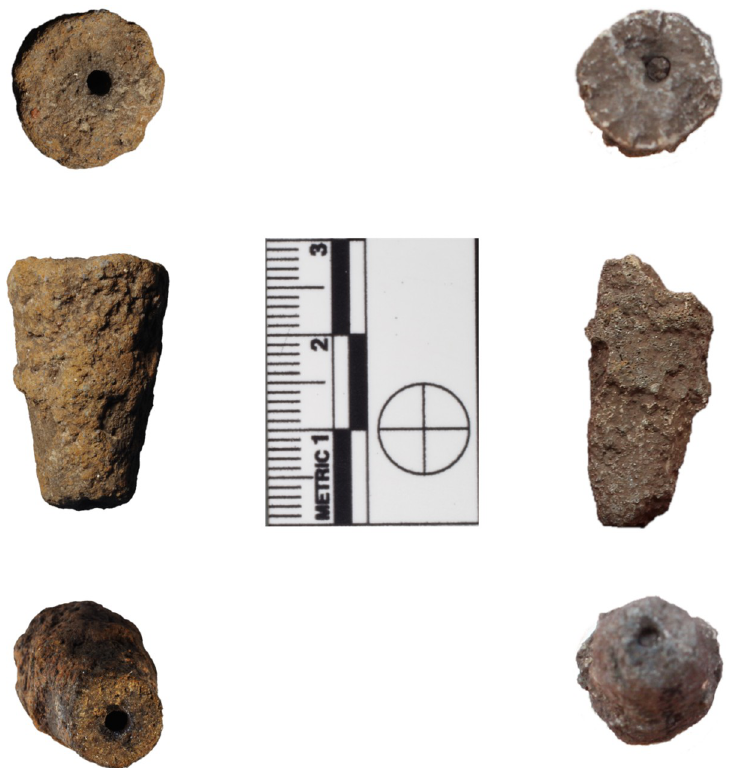
Fig 2. Possible tuy è res. Two tapered cylindrical ceramic pieces with hollow channels from Mayapa´n; we argue that they represent tuy è res, or blowpipe tips for metalworking: M-16 (left) and M-55 (right). Composite photographs include proximal, lateral and distal views, from top to bottom. Photograph by Elizabeth Paris and Jennifer